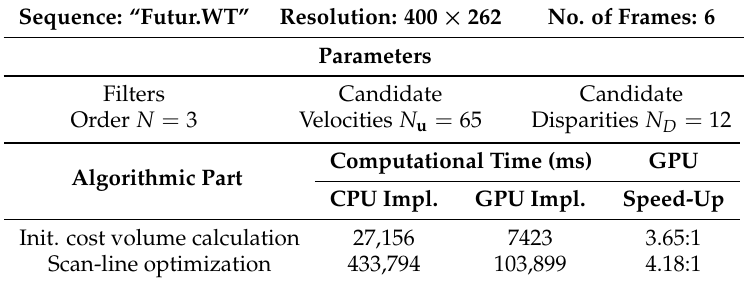
Table 1. Parameters and computational time (CPU vs. GPU) for the “Futuristic White-Tower” sequence. Sequence: